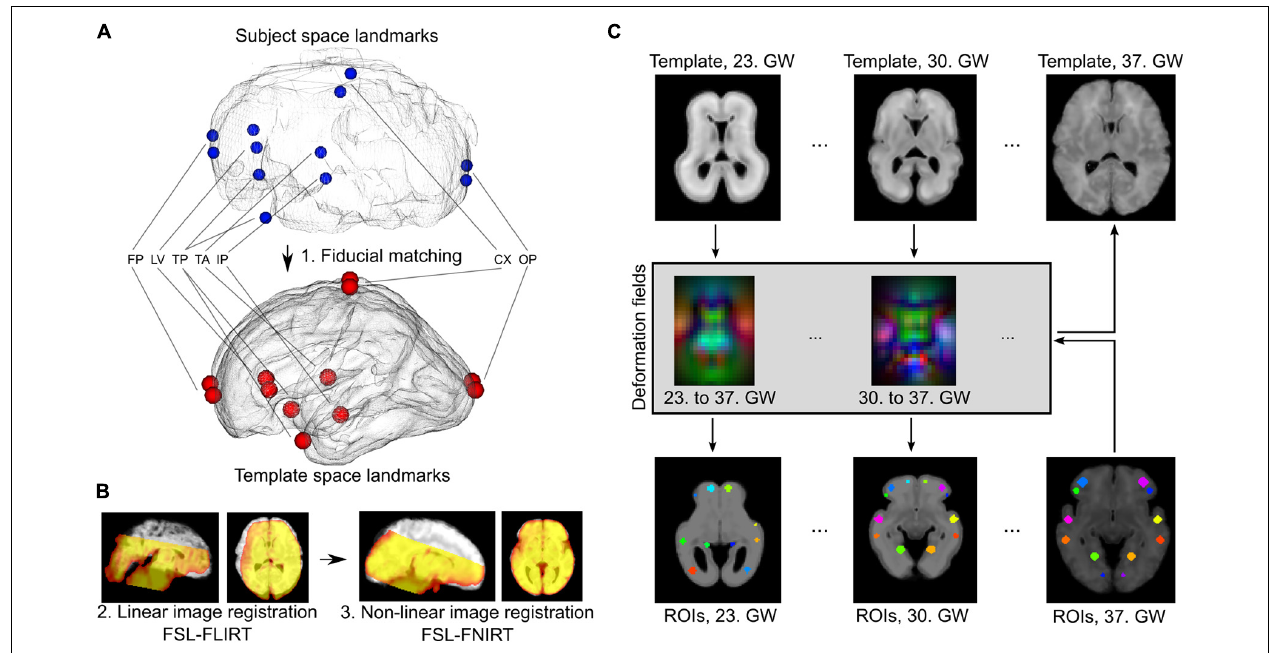
registration, carried out with intensity-based algorithms: linear (FLIRT) and non-linear (FNIRT) registrations in the FSL software. (C) Establishing GW-specific regions with a longitudinal label propagation approach. First row: for each GW from the 23rd to